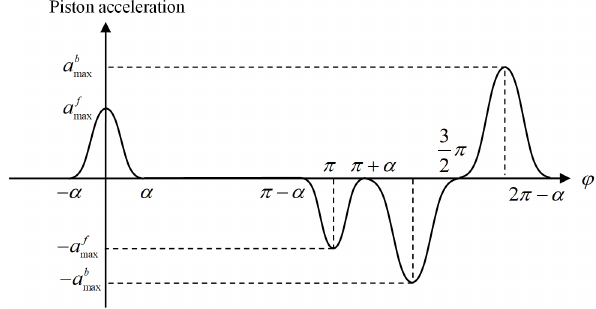
Figure 6. Piston acceleration of the two-piston pump per cycle.